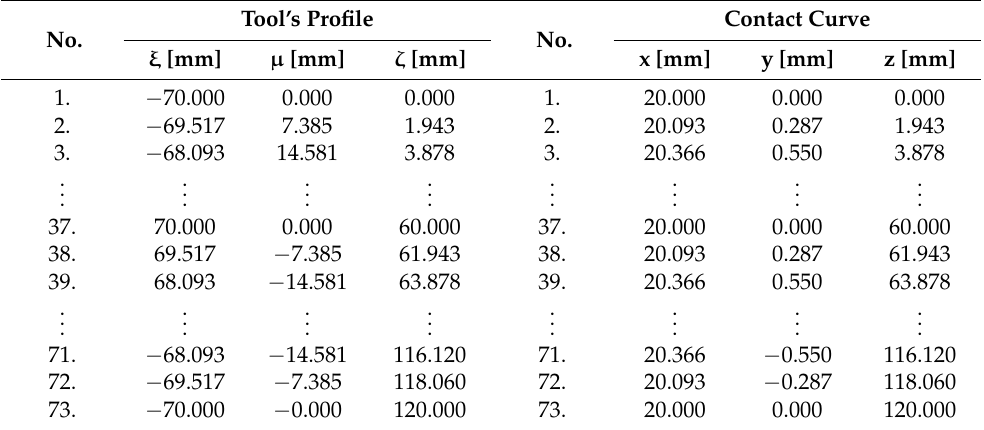
Table 1. The values table of the tool’s profile and the contact curve.